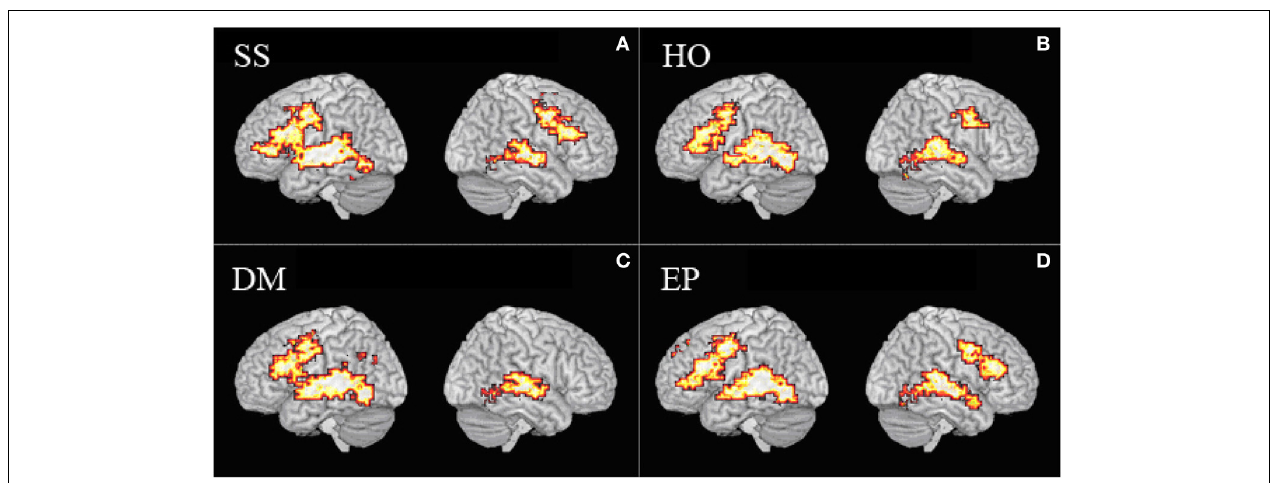
FIGURE 4 | Brain activation. (A) Activation during silent speechreading (SS). (B) Activation during processing of signs without any mouth actions (HO). (C) Activation during processing of signs with disambiguating mouth actions (DM). (D) Activation during processing of signs with echo phonology